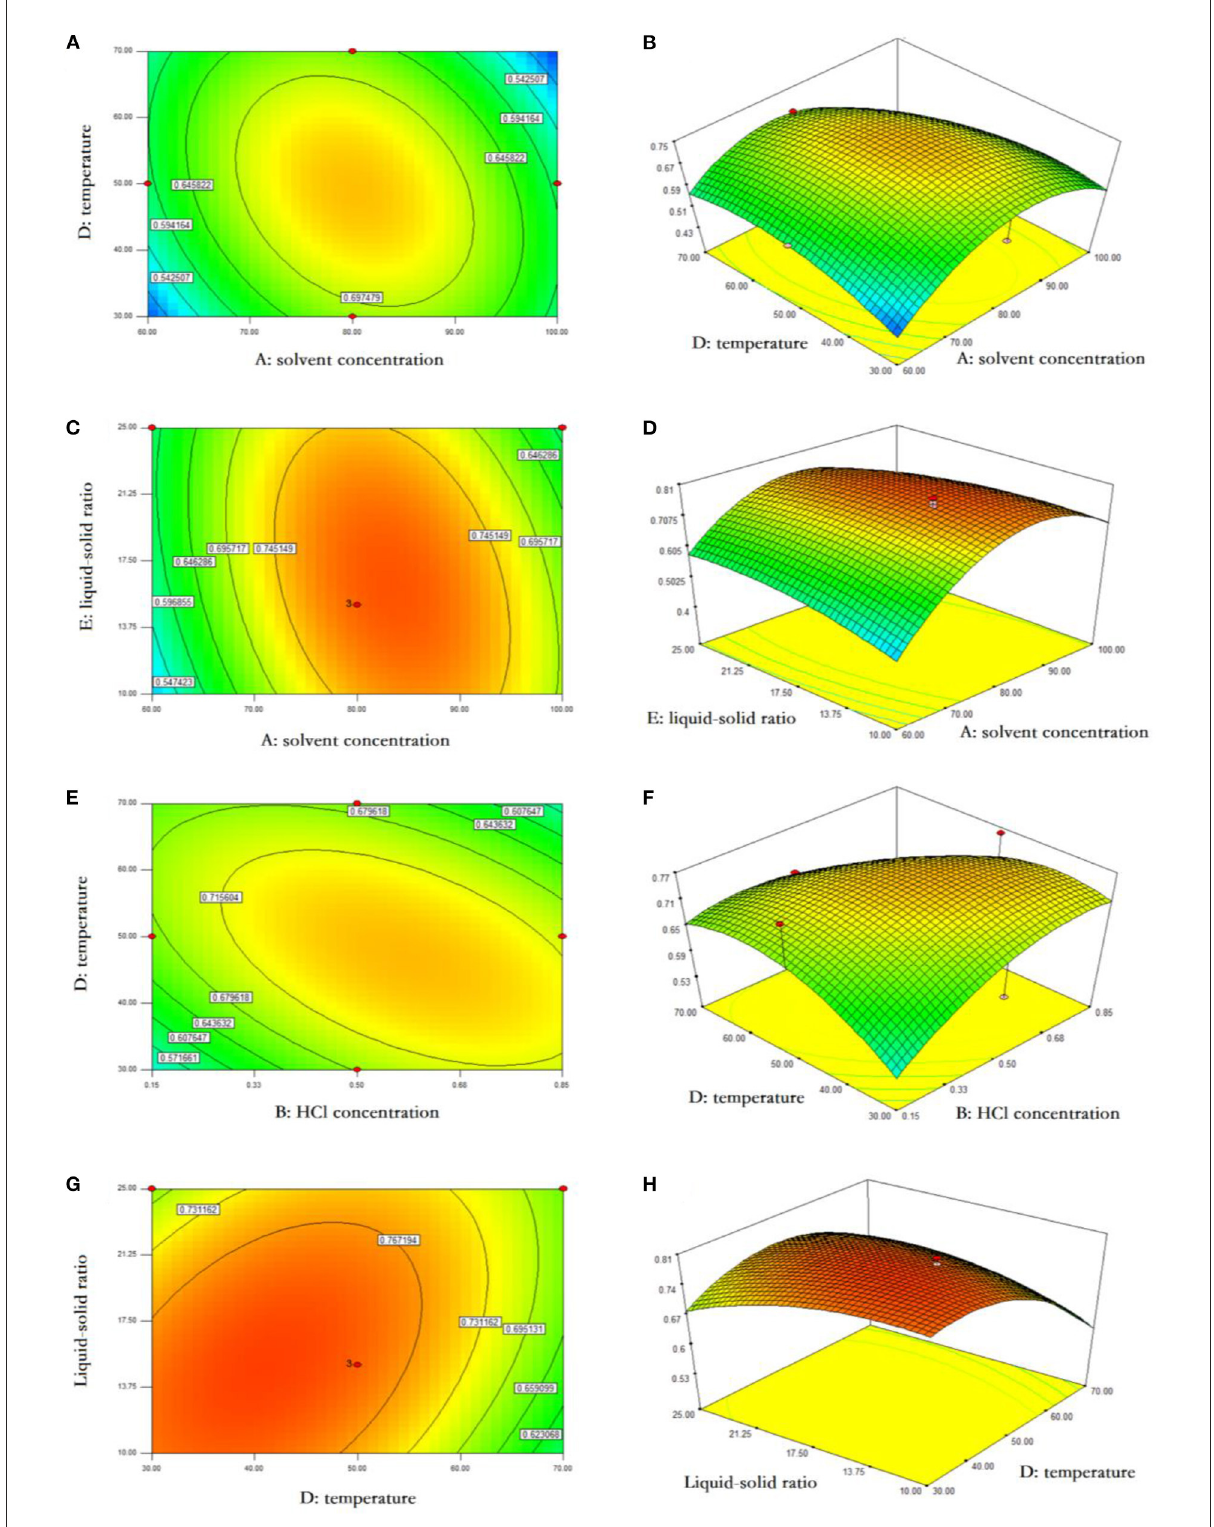
FIGURE2 Response surface analysis of anthocyanin extraction from blackberry. The interactive effects of ethanol concentration and extraction temperature (A,B) , ethanol concentration and liquid-solid ratio (C,D) , HCl concentration and extraction temperature (E,F) , and extraction temperature and liquid-solid ratio (G,H) on anthocyanin yield were presented using the response surface plots and contour plots,